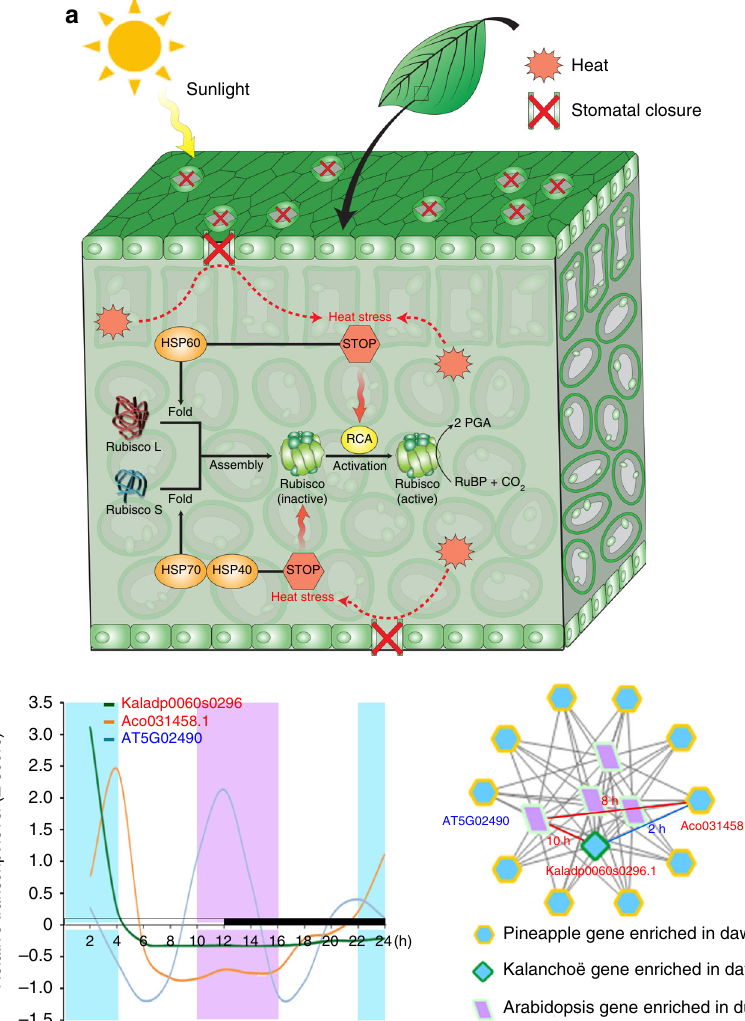
Fig. 8 Convergent changes in diel transcript expression of heat-shock proteins (HSPs) in CAM species in comparison with C 3 species. a Schematic representation of the possible roles of HSP40, HSP60, and HSP70 in leaf heat tolerance. b Comparison of diel transcript expression pattern of HSP70 between CAM species ( Kalanchoë fedtschenkoi and pineapple) and C 3 species ( Arabidopsis ). Left panel shows the diel transcript expression patterns. Right panel shows enrichment triangle network, in which a K. fedtschenkoi gene and a pineapple ortholog had signi fi cantly enriched expression in the same time- window, whereas an Arabidopsis ortholog had signi fi cantly enriched expression in the opposite time-window. The numbers are the time shifts in diel transcript expression pattern between genes connected by each edge. White and black bars indicate daytime (12-h) and nighttime (12-h), respectively. X -axis represents the time after the beginning of the light period. RuBisCO: Ribulose-1,5-bisphosphate carboxylase/oxygenase; RCA: rubisco activase; RuBP: ribulose-1,5-bisphosphate; PGA: